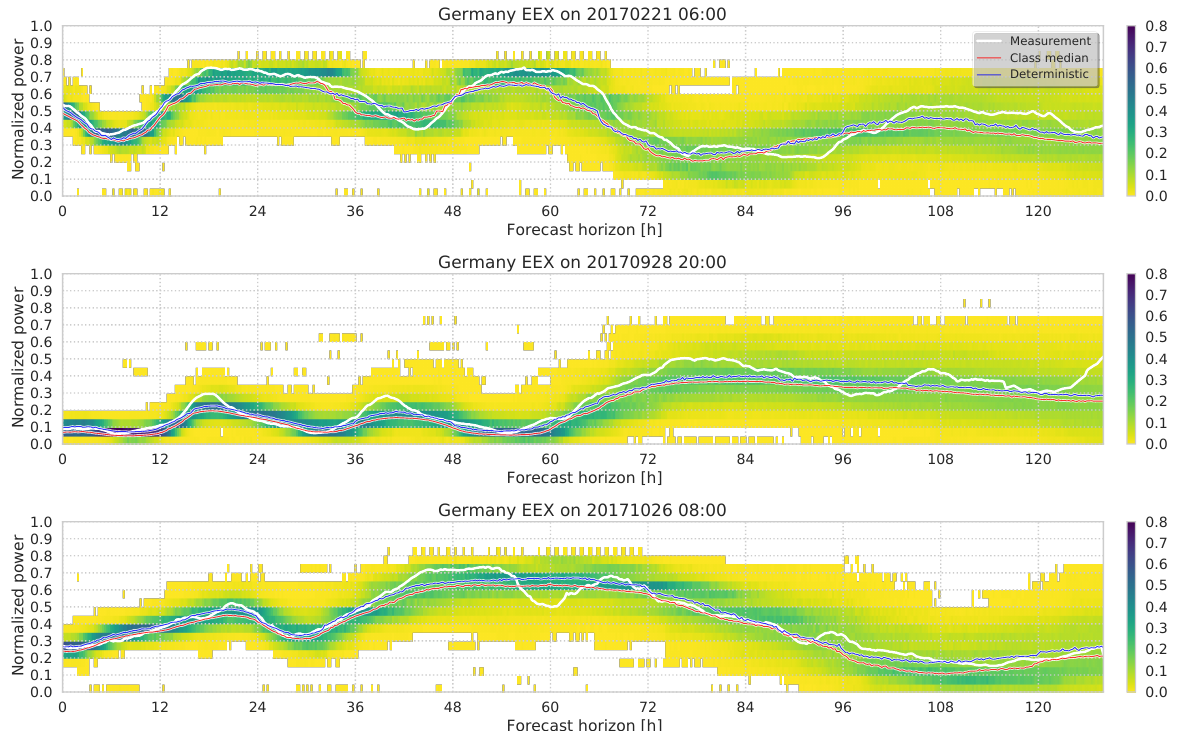
Figure 2. Example forecasts with raw probabilistic output. The shading indicates probability per normalised power bin. The median of the distribution and a deterministic reference run are also